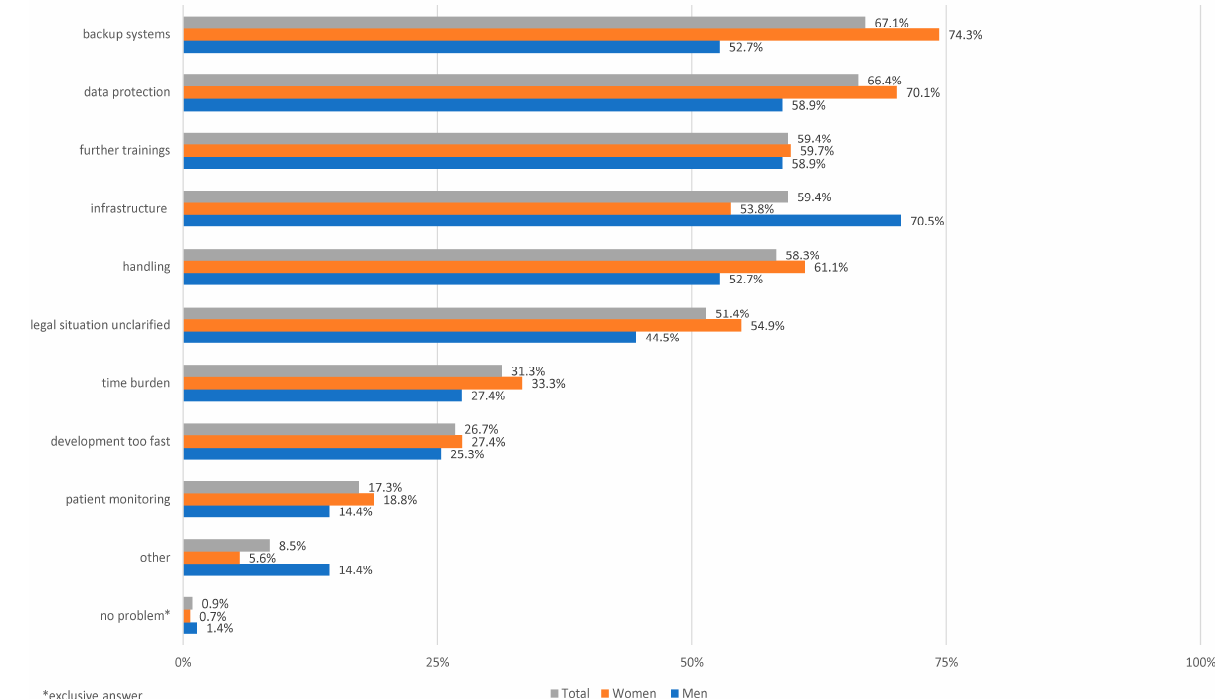
Figure 2. Illustration of the medical students’ assessment of potential problems of digitalization in medicine (multiple answers were possible; n = 434). Infrastructure, i.e., the necessary software and hardware to use respective tools or platforms in digital medicine; handling, i.e., confident handling of the digital applications; patient monitoring, i.e., data-based monitoring of patients (laboratory values, diagnostic results).